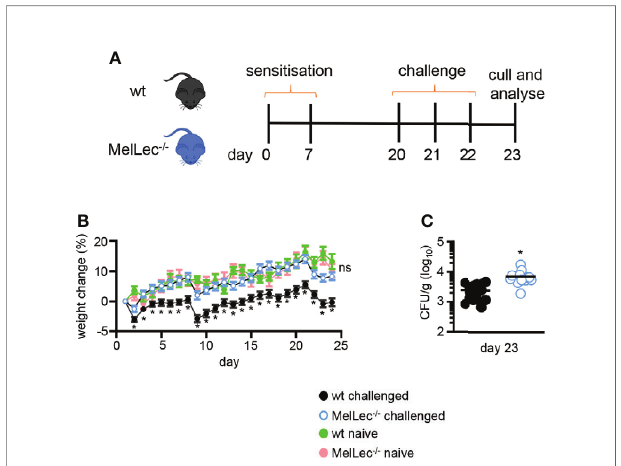
FIGURE 1 | Loss of MelLec protects against body weight loss. (A) Schematic representation of the allergic model used in these experiments. Wild type (wt) or MelLec-/- mice were sensitized by intratracheal administration with 1x10 7 live spores of Aspergillus fumigatus ATCC 13073 on days 0 and 7, and then similarly challenged on days 20, 21, and 22. Mice were sacri fi ced on day 23, 24 hrs after the last-challenge and analyzed. (B) Percentage body weight change over the course of the experimental model and naïve Wild type (wt) or MelLec -/- mice, as indicated. Pooled values shown are mean ± SEM of fi ve independent experiments (n>40 mice per group). (C) Lung fungal burdens of mice on day 23. CFU, colony-forming unit. Shown are pooled data (with mean) from two independent experiments (n=16 mice). *p<0.05. Statistical signi fi cance was determined using t-tests. n.s., not signi fi